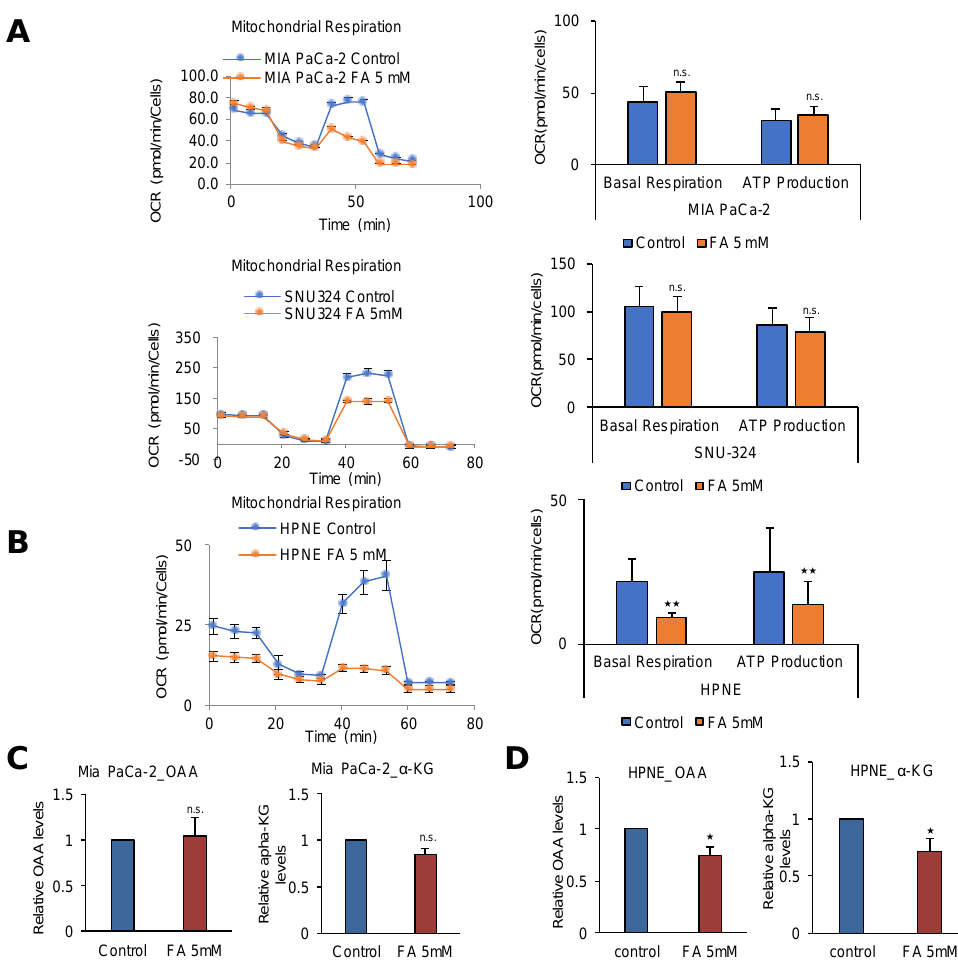
Figure 3. The TCA cycle is not involved in ATP production in PDAC cells. ( A ) OCR was analyzed using the Seahorse XFe96 analyzer. OCR in response to 5 mM of FA in MIA PaCa-2, SNU-324, and ( B ) normal HPNE cells. ( C ) The levels of OAA and α -KG were measured after treatment of MIA PaCa-2 cells with 5 mM of FA for 24 h using OAA colorimetric / fluorometric assay kit and α -KG colorimetric / fluorometric assay kit. ( D ) The levels of OAA and α -KG were measured after treatment of HPNE cells with 5 mM of FA for 24 h. Abbreviations: FA, fluoroacetate. OAA, oxaloacetate. α -KG, α -ketoglutarate. n.s. (not significant), * p < 0.05, ** p < 0.01 compared with the vehicle control.